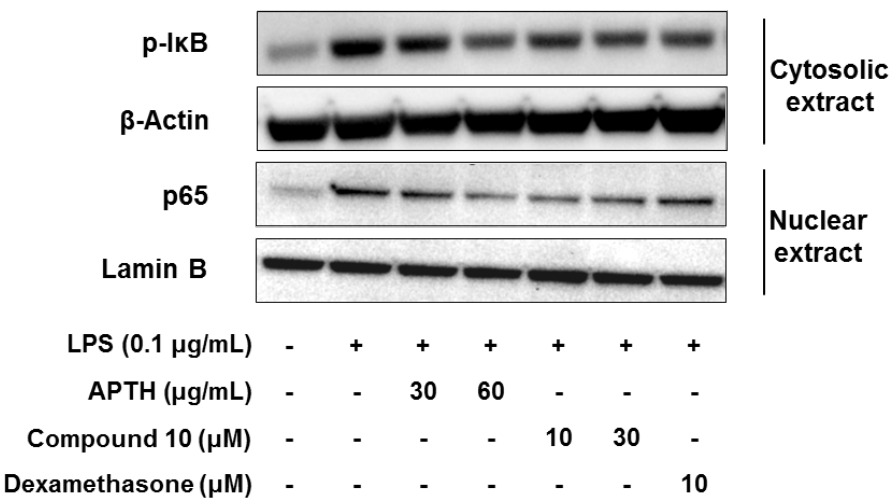
Figure 4. Effects of APTH and compound 10 on NF- κ B signaling pathways in LPS-treated RAW264.7 macrophages. Cells were pretreated for 1 h in the presence or absence of samples and then stimulated for 1.5 h with LPS (0.1 µ g/mL). Cell cytosolic and nuclear extracts were prepared to determine whether I κ B phosphorylation levels and p65 translocation to the nucleus. β -Actin and Lamin B were used as loading controls. Dexamethasone served as the positive control.